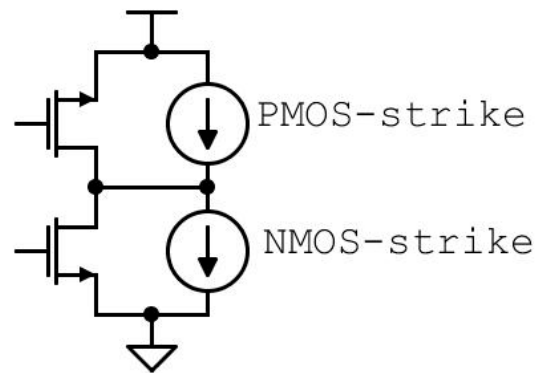
Figure 12. The model used for the correct stimulation of the P-N junction with the double exponential current pulses generators. current pulses generators.